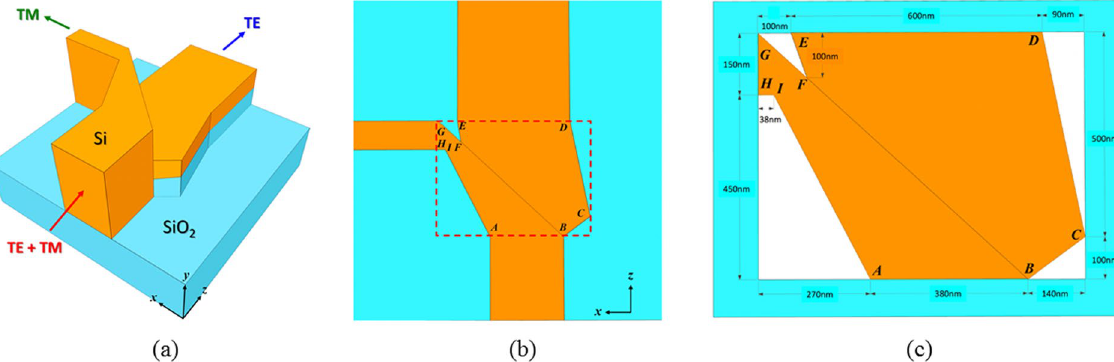
Figure 1. ( a ) A 3D schematic diagram of the proposed PBS, which consists of two slanted Si waveguides with different aspect ratios adjoined side-by-side and deposited on a SiO 2 substrate; the input (launching the TE and TM modes simultaneously) and the two output (separating the TE and TM modes) channels connected to the PBS are also shown. ( b ) A view from above the proposed PBS, where the closed dashed line denotes the device extent. ( c ) The zoomed-in view of the device extent shown in ( b ).